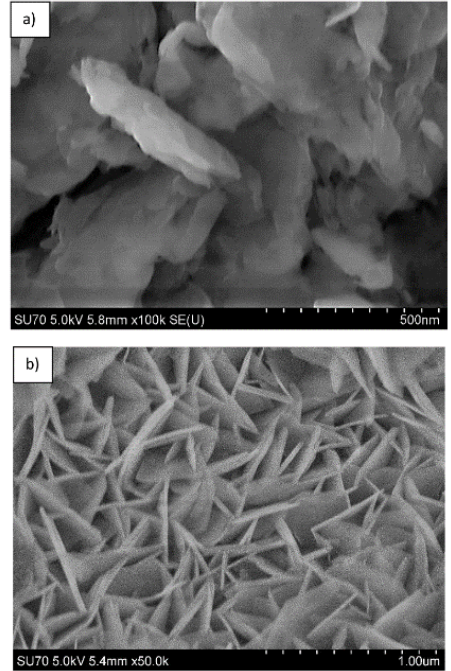
Figure 9. SEM micrographs of Mg 3 /Al-CO 3 ( a ) and Mg 3 /Al 0.99 Eu 0.01 -CO 3 ( b ) LDHs.